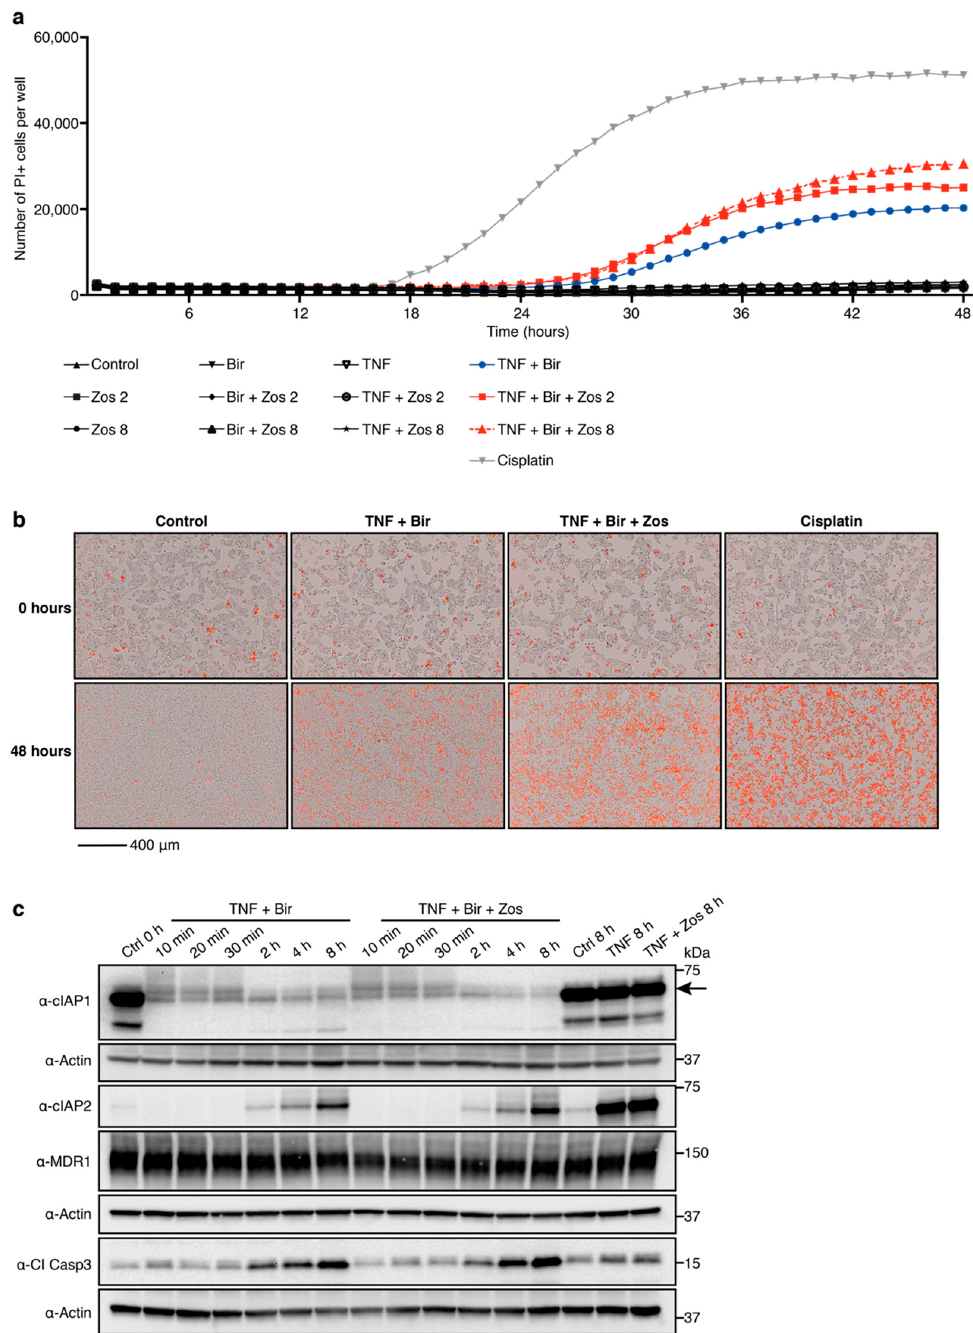
Figure 1. Multidrug resistance protein 1 (MDR1) inhibition enhances birinapant-mediated killing of HepG2 cells. ( a , b ) HepG2 cells were cultured with propidium iodide (PI) for 3 h prior to the addition of birinapant (bir) 10 µ M ± zosuquidar (zos) 2 or 8 µ M ± tumor necrosis factor (TNF) 200 ng / mL; treatment with cisplatin 80 µ M was used as a positive control. Analysis of cell death kinetics were performed on an Essen IncuCyte S3. ( a ) Number of PI positive cells per well over 48 h. Plotted is the mean of 3 biological repeats and is representative of 3 independent experiments. ( b ) Visual images of HepG2 cells at 0 and 48 h. One representative experiment of 3 independent experiments is shown, with 3 biological repeats per condition. Red cells are PI positive. Scale bar, 400 µ m. ( c ) HepG2 cells were treated with birinapant 10 µ M ± zosuquidar 2 µ M ± TNF 200 ng / mL for the indicated times. Whole cell lysates were probed with the indicated antibodies. Actin was used as a loading control. Representative of 3 independent experiments. Cl, cleaved; Casp, caspase.